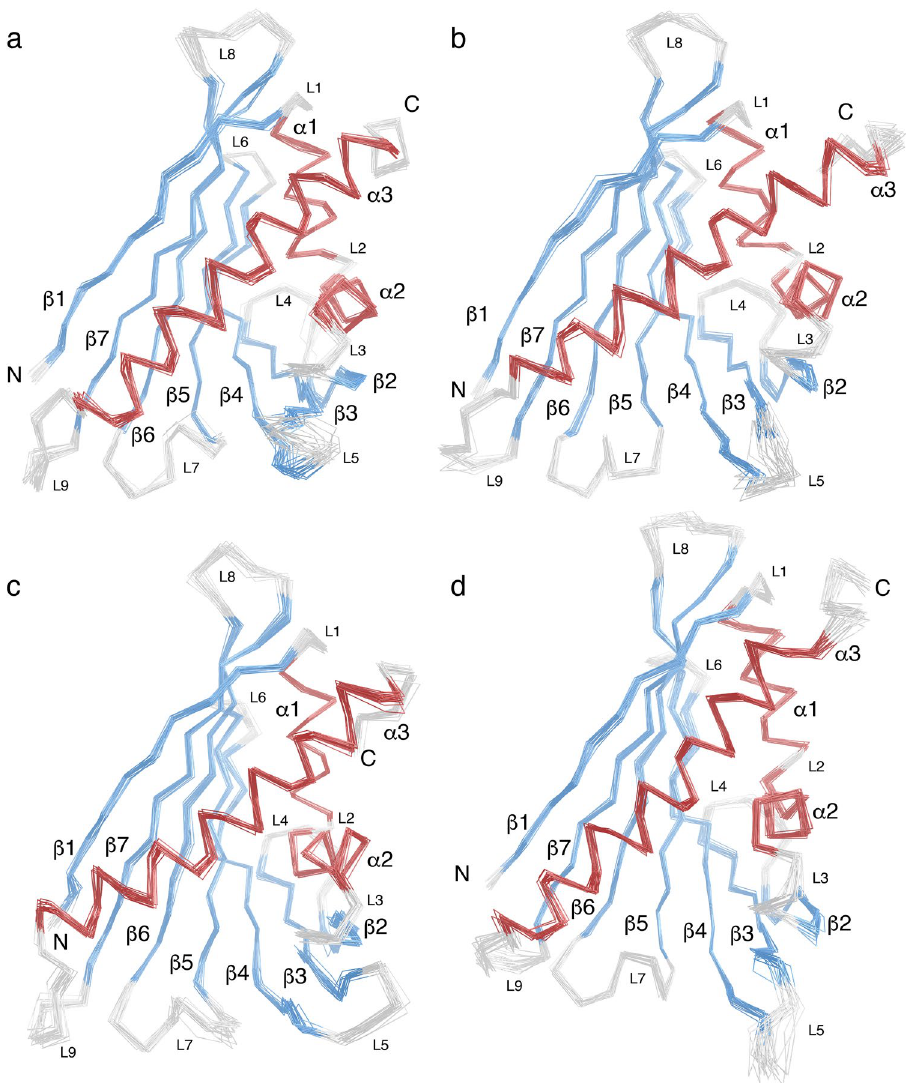
Figure 1. Backbone overlay of the 20 NMR solution structures with the lowest energy of the four hazelnut allergens Cor a 1.0401 ( a ), Cor a 1.0402 ( b ), Cor a 1.0403 ( c ), and Cor a 1.0404 ( d ), with the PDB codes 6Y3H, 6Y3I, 6Y3K, and 6Y3L, respectively. The secondary structure elements are defined as β1 (Val2–Ser11), α1 (Pro15–Leu24), α2 (Ala26–Ala34), β2 (Thr39–Glu45), β3 (Gly51–Ala59), β4 (Phe64–Asp75), β5